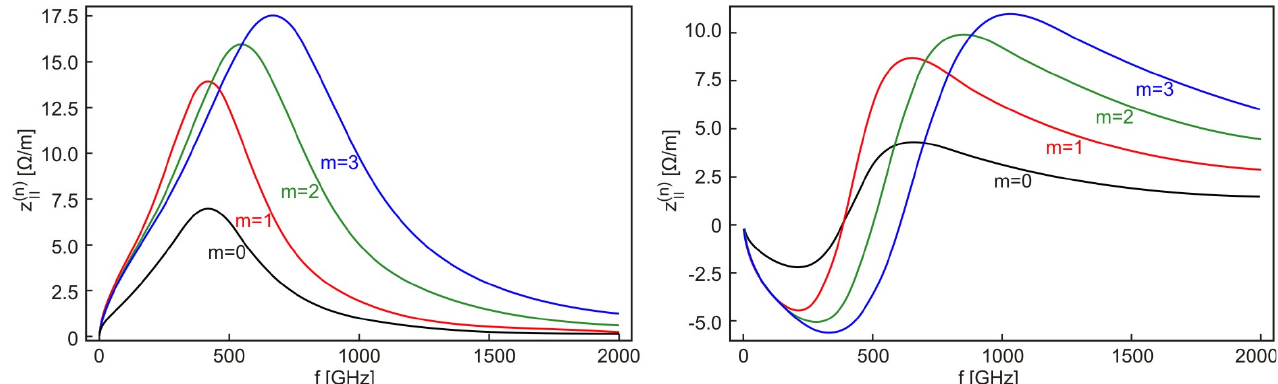
FIG. 2. (Color) Real (left) and imaginary (right) parts of longitudinal multipole impedances for PETRA III vacuum chamber. Standard straight